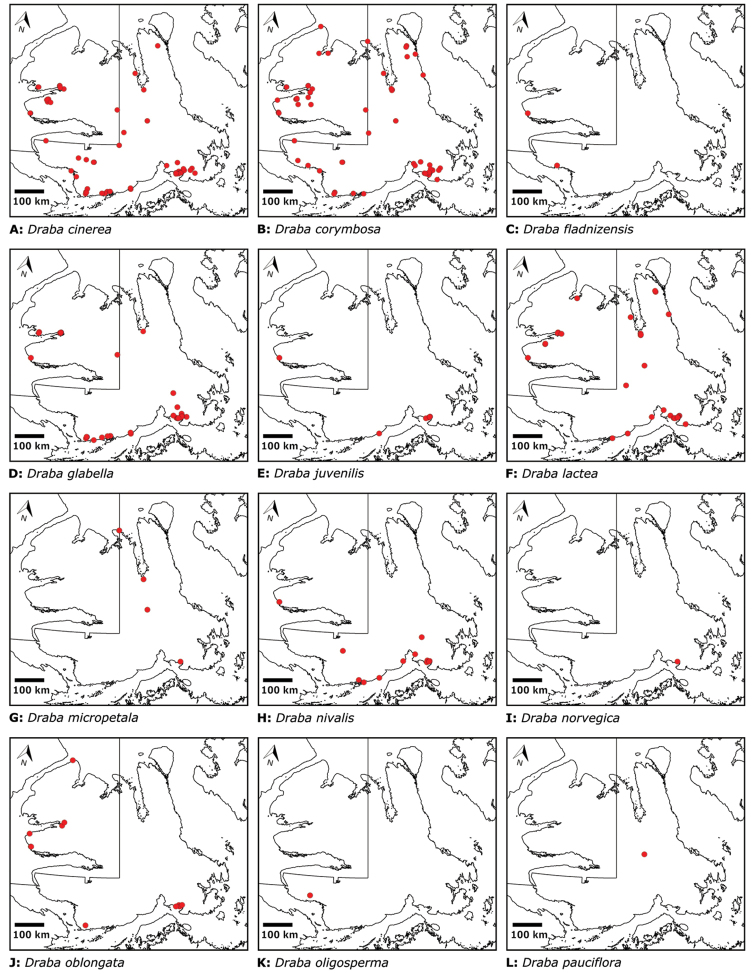
Species distribution maps. Brassicaceae: ADraba
cinereaBDraba
corymbosaCDraba
fladnizensisDDraba
glabellaEDraba
juvenilisFDraba
lacteaGDraba
micropetalaHDraba
nivalisIDraba
norvegicaJDraba
oblongataKDraba
oligospermaLDraba
pauciflora.